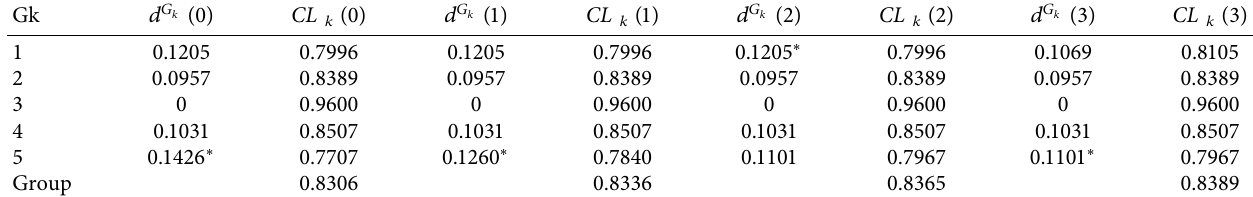
Table 18: .e adjustment process without considering the interactive weights.